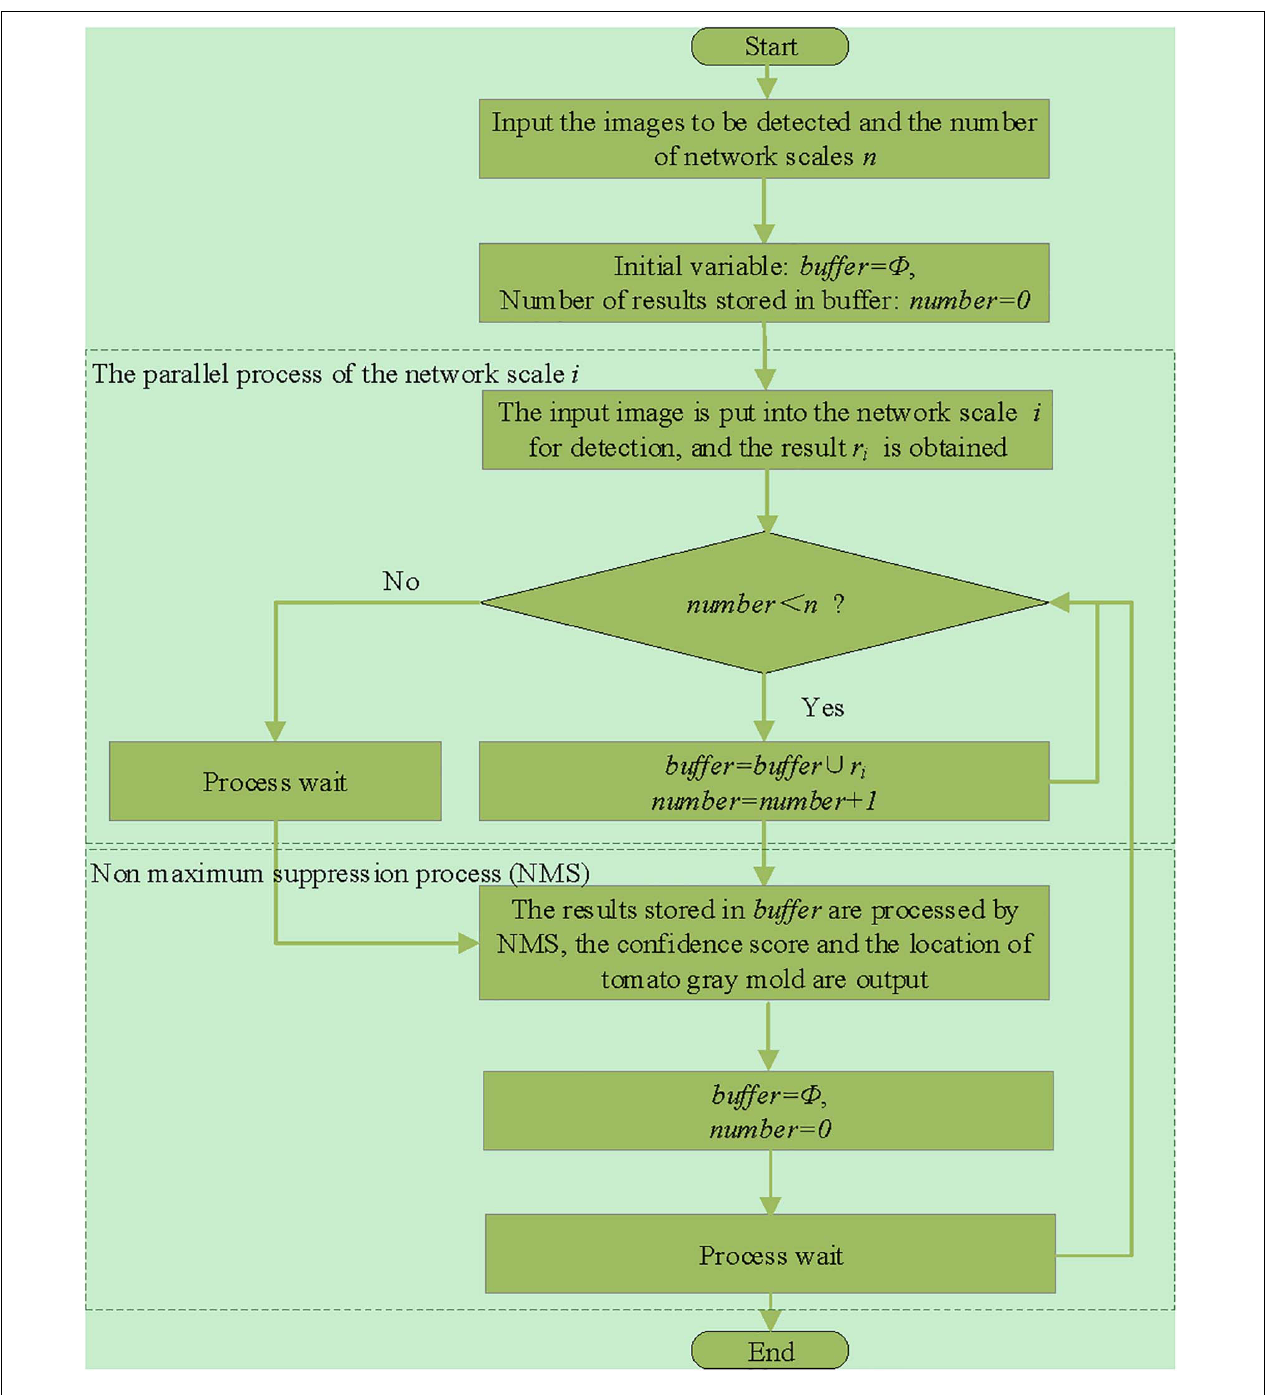
FIGURE 3 | Flowchart of the parallel detection algorithm.